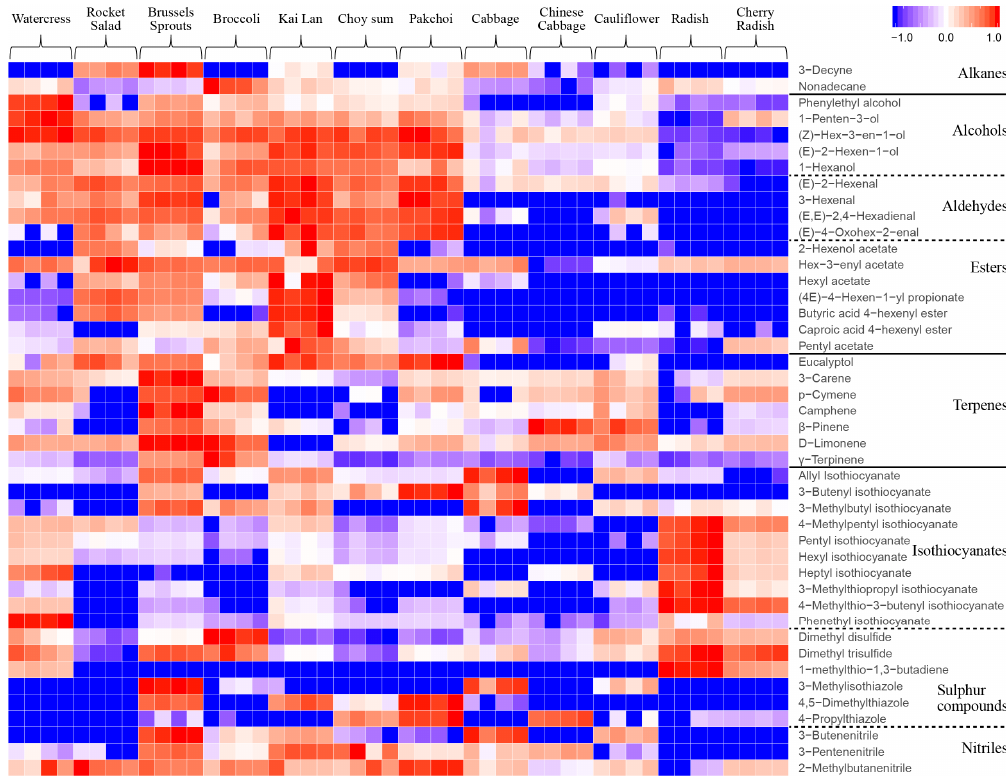
Figure 2. Heatmap of VOCs emitted from 12 Brassicaceae vegetables. The levels of each VOC in the 12 vegetables were normalized in the range of − 1 to 1. Blue ( − 1) and red (1) represent the lowest and highest levels, respectively.